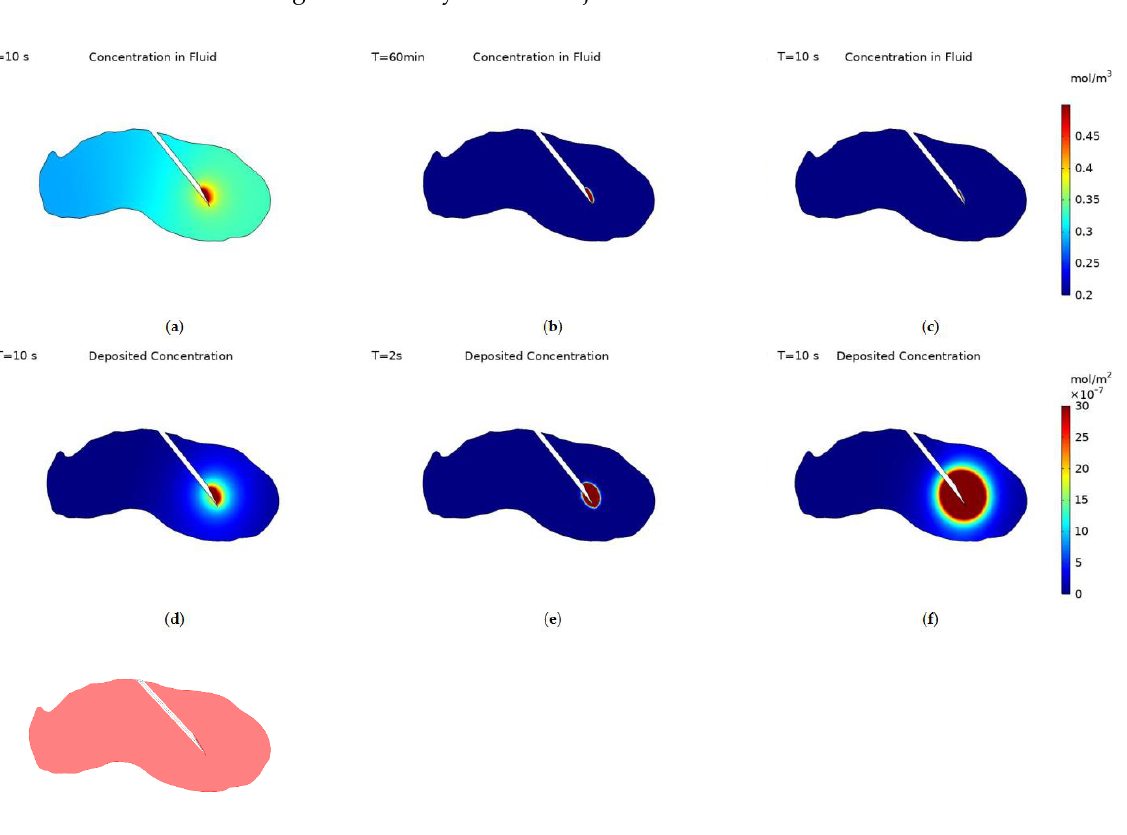
Figure 4. Concentration contours of nanoparticles within the fluid at the end of injection, with surface charge; ( a ) − 30 mV, ( b ) 0 V and ( c ) +30 mV, and deposited onto cell surfaces, with surface charge; ( d ) − 30 mV ( e ) 0 and ( f ) +30 mV, ( g ) a schematic of the cut-plane used to plot the results.